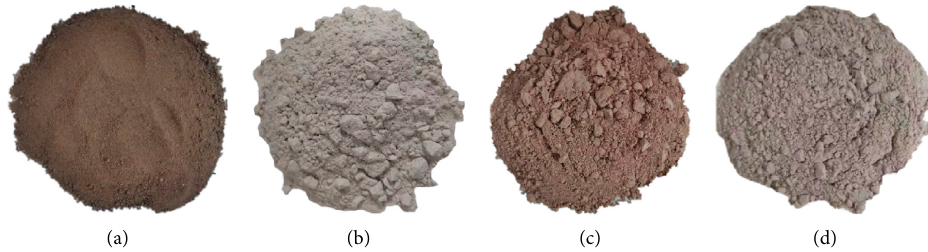
Figure 1: Test of raw materials. (a) Silty sand. (b) Lime. (c) MK. (d) NHL.